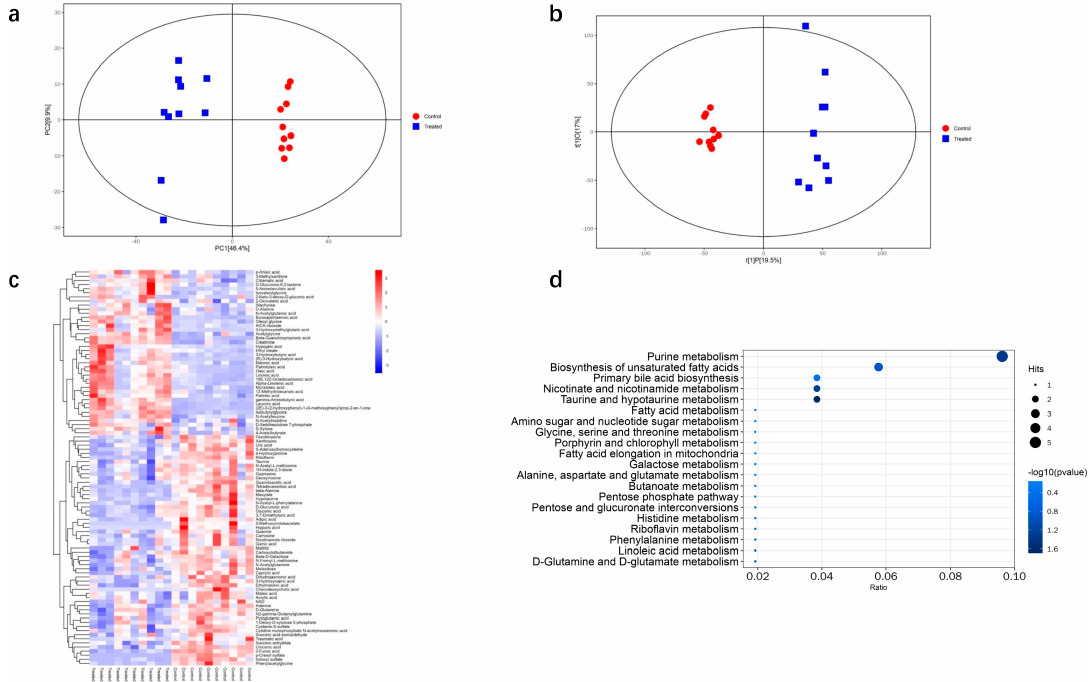
Figure 5. Metabolomic analysis of DQ-treated mice. ( a ) PCA of the metabolic pro fi les ( N = 10). ( b ) Score plots of the OPLS-DA model classifying the DQ-treated and control groups. ( c ) Heatmap anal- ysis of the di ff erently expressed metabolites between the DQ-treated and control groups. The col- umns show the signi fi cantly upregulated (red) or downregulated metabolites (blue) in the di ff erent groups. ( d ) KEGG pathway analysis based on the di ff erently expressed metabolites identi fi ed in the DQ-treated and control groups.